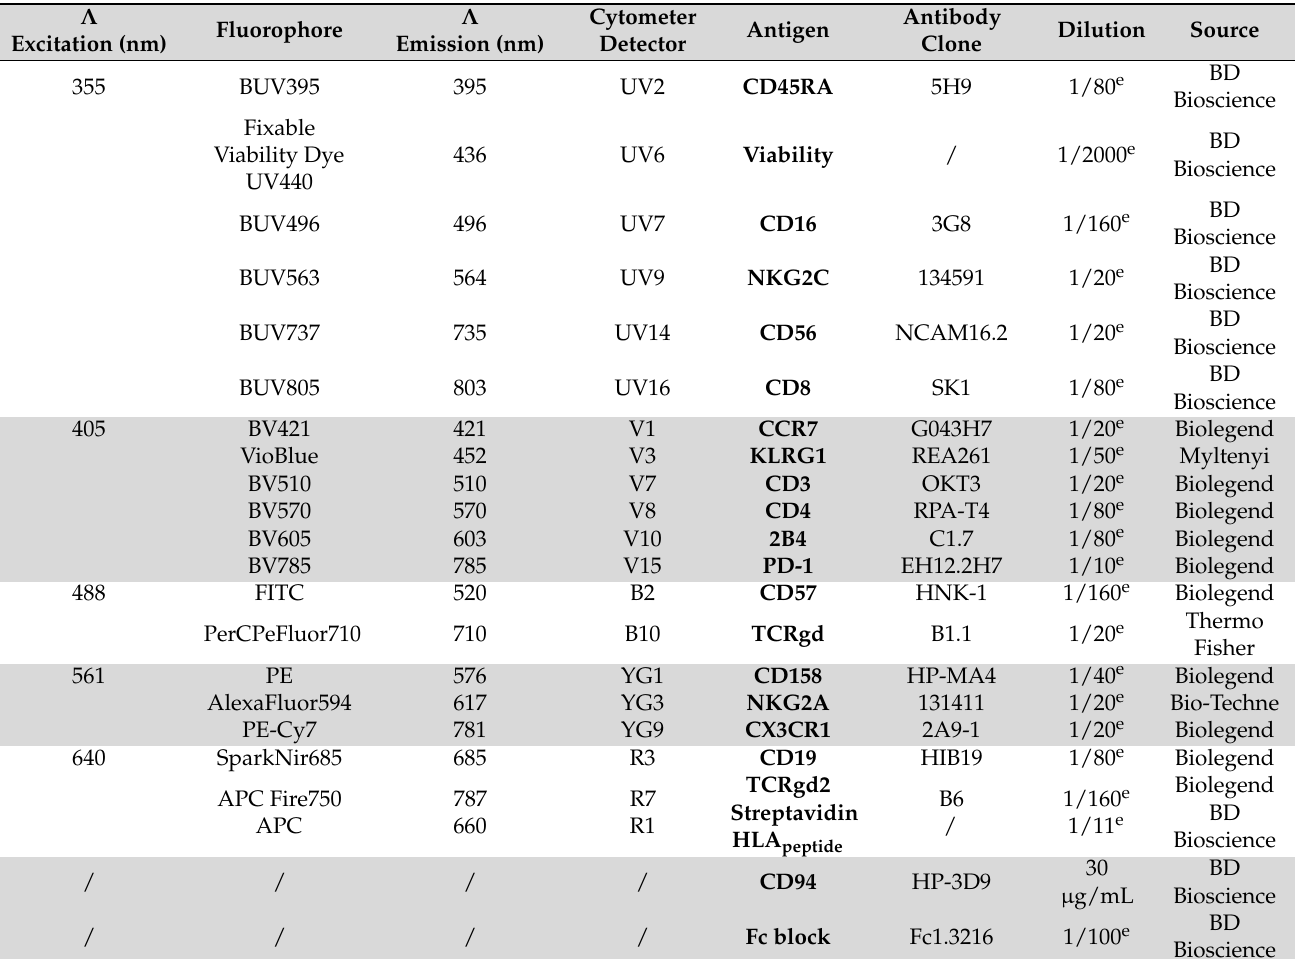
Table 1. Antibody panel and HLApeptide tetramers used for anti-HCMV immune profiling using spectral flow cytometry. Antigen, fluorophore, clone, and dilution are